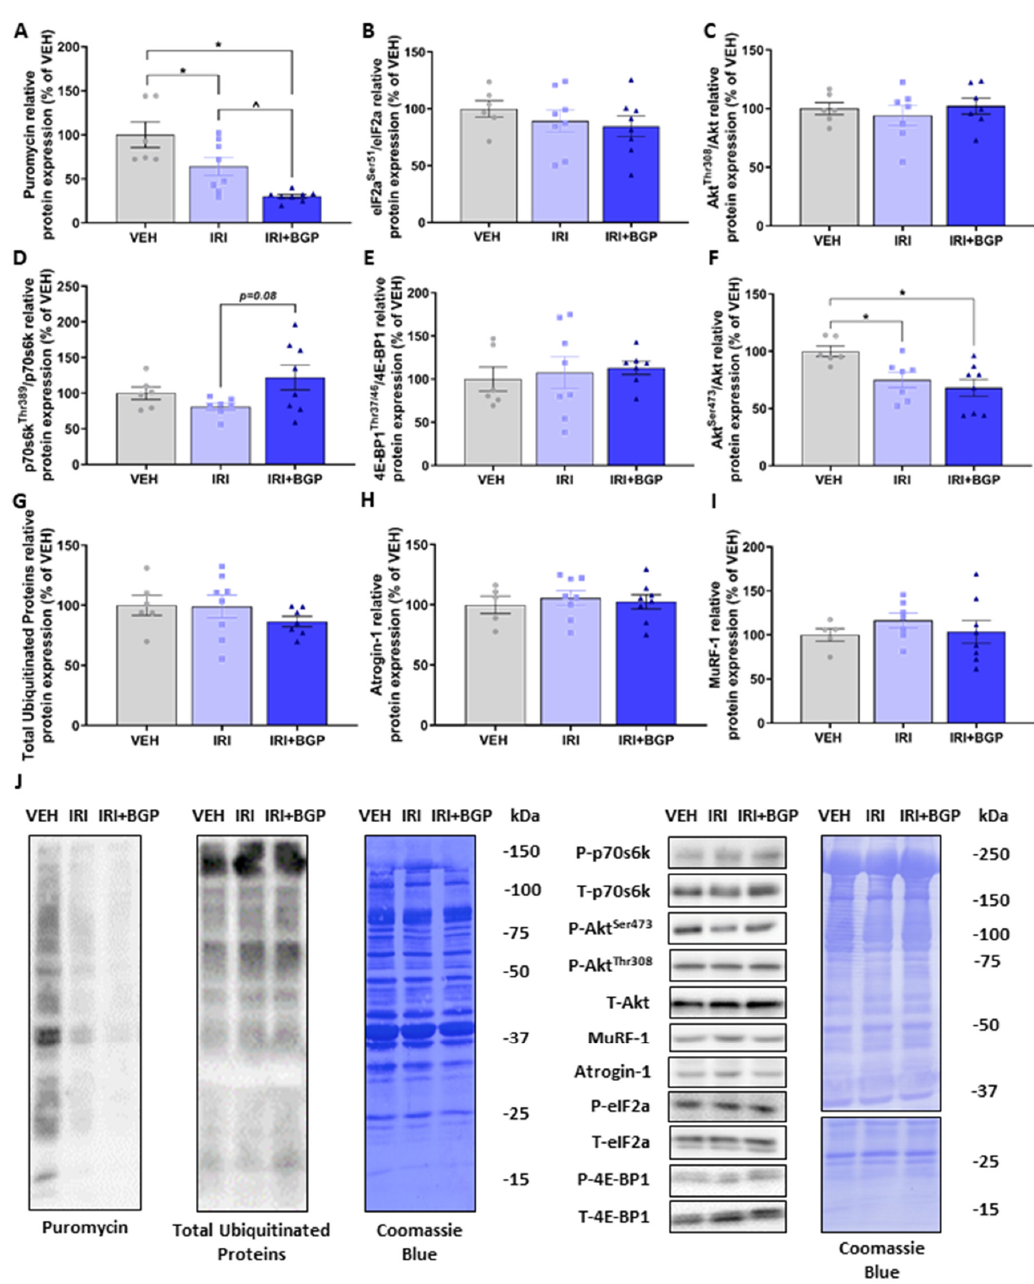
Figure 3. The effect of irinotecan (IRI) and IRI with BGP-15 (IRI+BGP) treatment on protein synthesis and degradation signaling. Western blotting experiments were undertaken on tibialis anterior (TA) homogenate—data are expressed as a relative percentage of the vehicle (VEH) control group. Samples were probed for ( A ) puromycin as a marker of protein synthesis via the surface sensing of translation (SUnSET) method, ( B ) eIF2a Ser51 relative to total eIF2a, ( C ) Akt Thr308 relative to total Akt, ( D ) p70s6k Thr389 relative to total p70s6k, ( E ) 4E-BP1 Thr37/46 relative to total 4E-BP1, ( F ) Akt Ser473 relative to total Akt, ( G ) Ubiquitin, (H) Atrogin-1 and ( I ) MuRF-1. ( J ) Western blot representative images are displayed alongside a Coomassie Blue representative image, which was used as the protein loading control. * = p < 0.05 compared to VEH, ^ = p < 0.05 compared to IRI; n = 5–8.